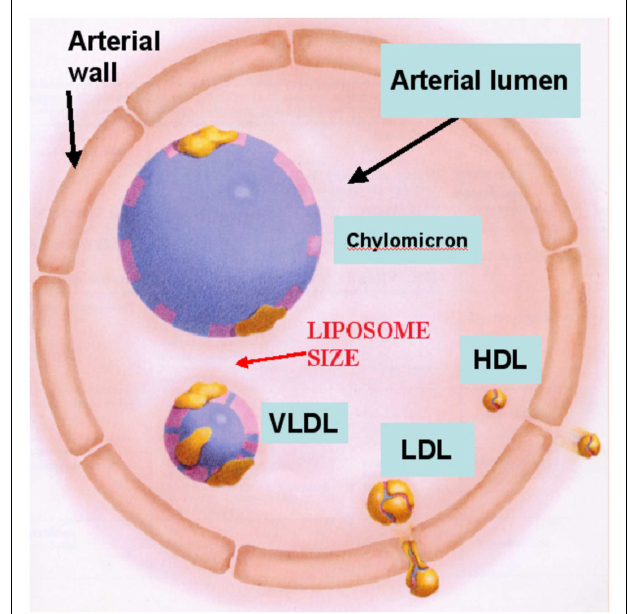
FIGURE 1 | Size comparison of HDL with liposomes and other lipoprotein classes .The rHDL nanoparticles have an average diameter